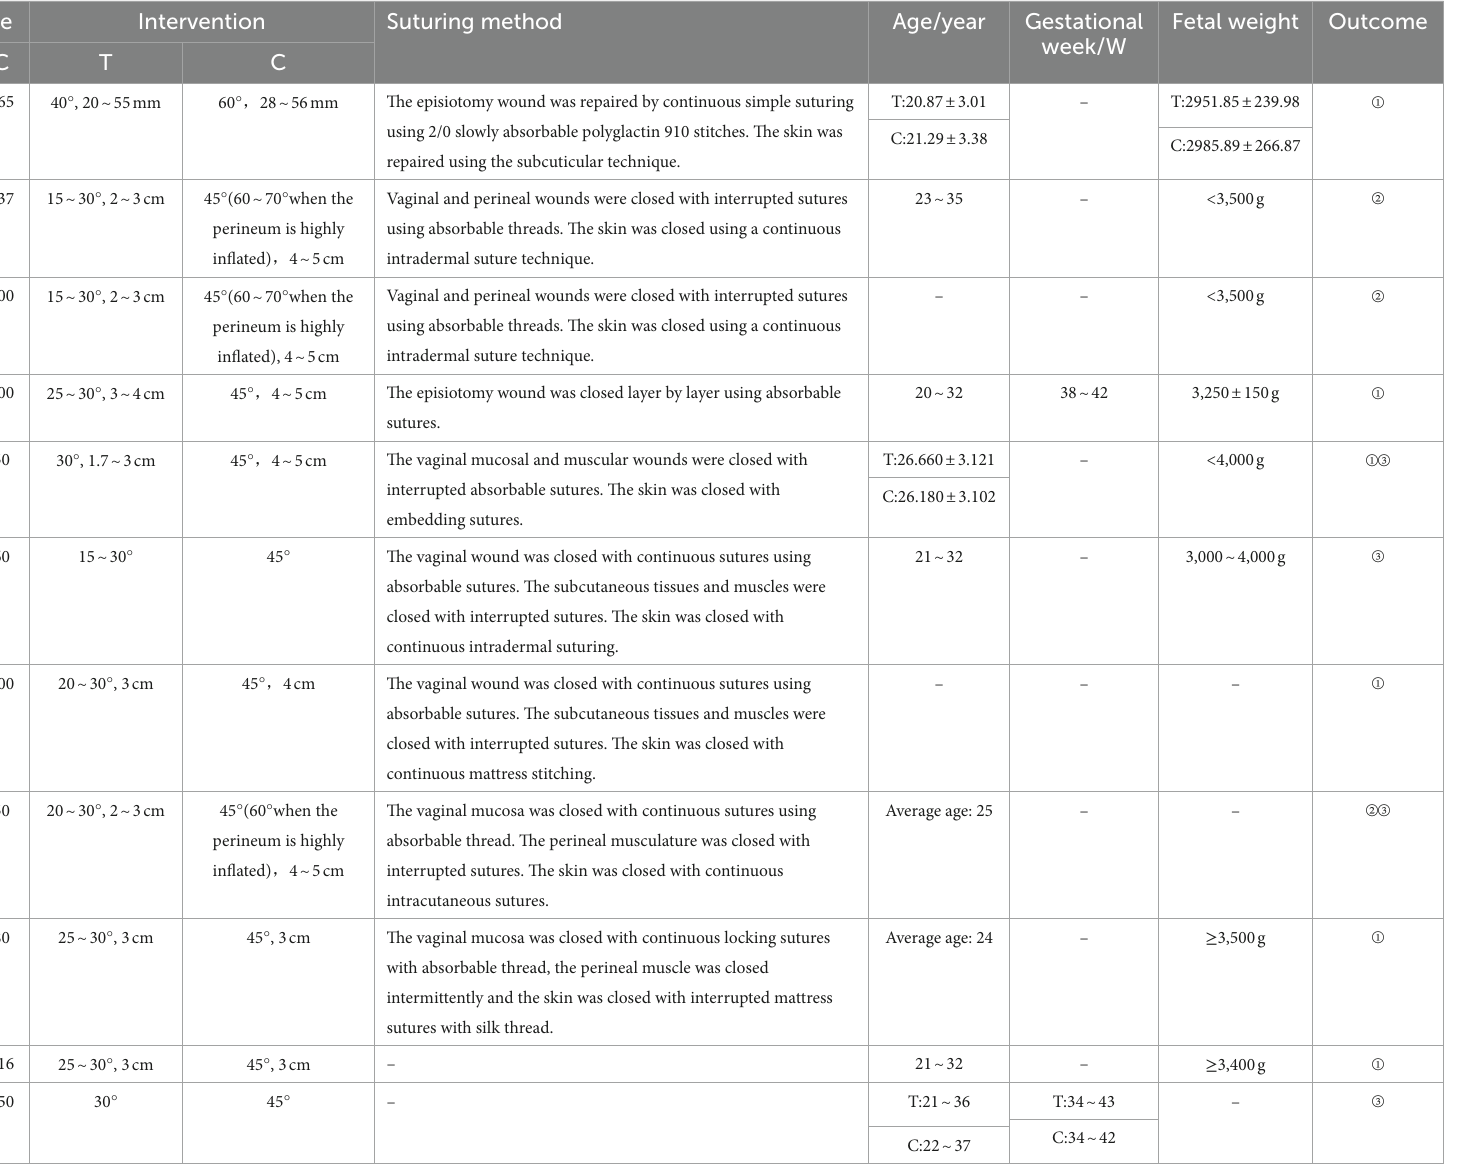
TABLE 1 Basic characteristics of the included